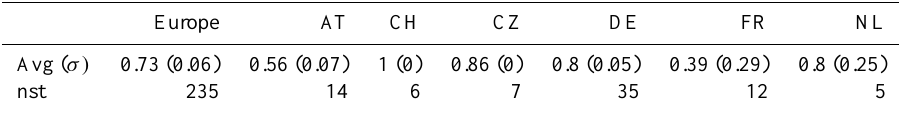
Figure 8 : (a) European-wide composite of modelled and observed monthly means of NO 2 trend (µg/m3) at the air quality monitoring stations of background suburban and rural type. The straight line shows the best linear least square fit. (b) scatter plot of modelled and observed trend (computed as linear least square of the de-seasonalised time series, in µg/m3/yr) at each individual station. Sites where a significant slope is computed are marked with a filled symbol. Table 5. Fraction of sites where the sign of the NO 2 trend is correctly captured by the models (average – avg – and standard deviation – σ – of the individual fraction correct of each model) for the countries where a significant trend is observed at 5 stations at least (number of selected stations – nst – provided on the last